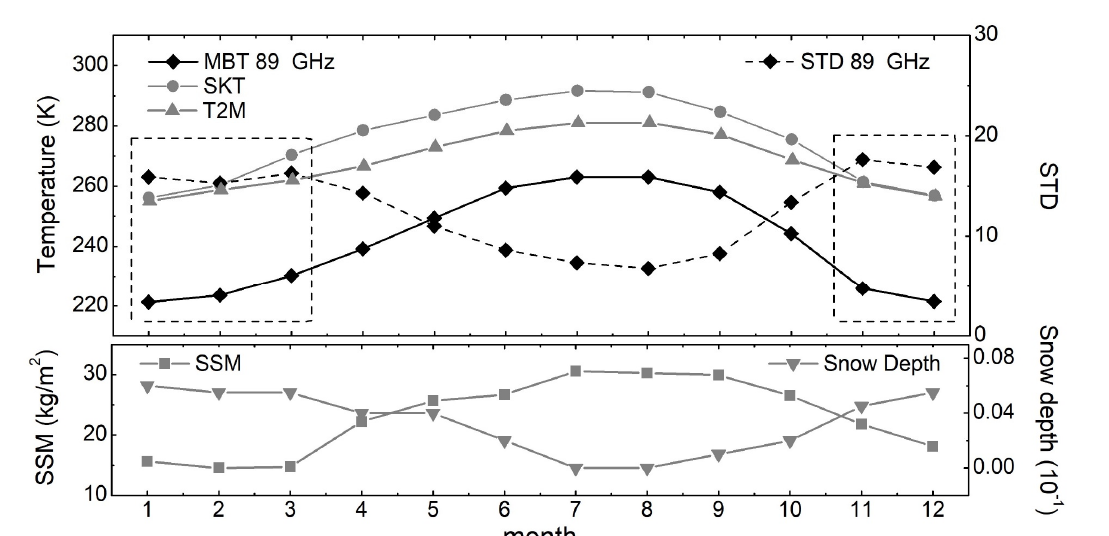
Figure A2. Variations of MBT background and STD at 89 GHz, SKT, T2M, SSM and snow depth in region C.